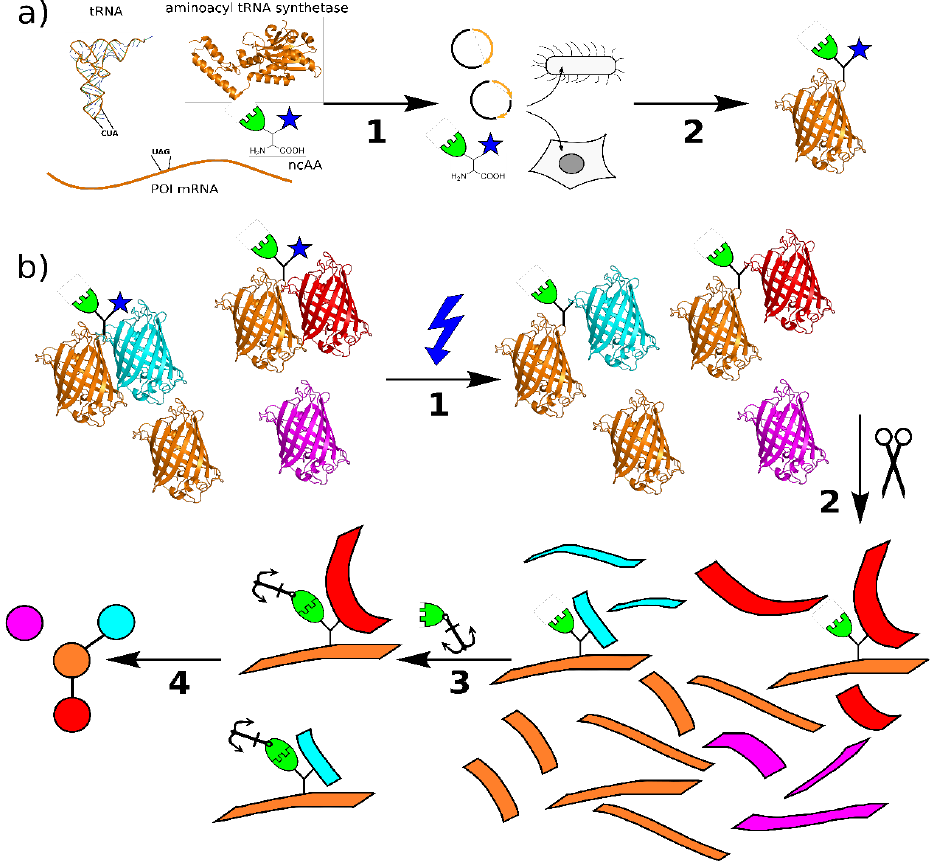
Figure 1. ( a ) Principle of genetic code expansion: The four components required are the mRNA for the target protein with a stop codon at the intended incorporation site, a tRNA complementary to this codon, the non-canonical amino acid, and an aminoacyl-tRNA synthetase that recognizes and connects the tRNA complementary to the TAG stop codon (tRNA CUA ) and non-canonical amino acid (ncAA). In step 1, these components are introduced into the host organism, e.g., by transient transfection, which then produces the protein of interest (POI) with the ncAA at the selected site in step 2. ( b ) Principle of protein interaction analysis using bifunctional amino acids: The POI incorporating the bifunctional ncAA binds to its native interaction partners in vitro or in vivo. Upon irradiation with UV light (1), a covalent bond is formed between the photo-crosslinker (blue) and the binding partner. The sample is processed by protease digestion (2) and the peptides containing the ncAA are labeled via the click chemistry handle (3). The relevant peptides are enriched by pulldown and analyzed by mass spectrometry. From these data. the protein interactions can be mapped (4) (structures: PDB 1EHZ, 6AAC, and